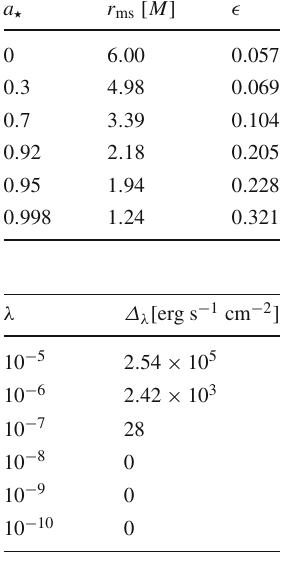
Table 2 The r ms and the efficiency (cid:2) for RDSWH. They are the same as those of Kerr BH. The general relativistic Schwarzschild black hole corresponds to a (cid:4) = 0. Here